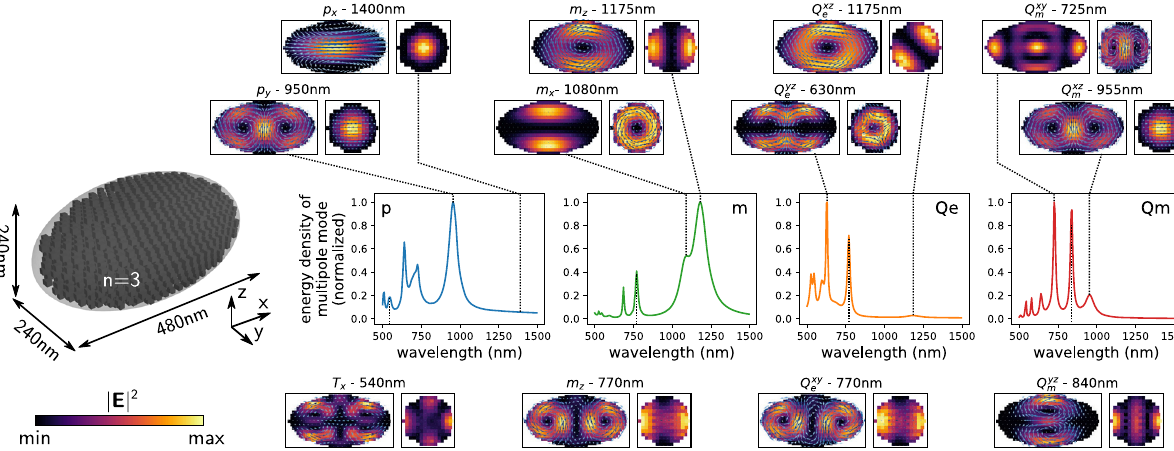
Figure 4: Spectra of the normalized total mode energy density for the different multipoles in a dielectric spheroid of constant refractive = 240 nm, R = 120 nm, and R = 120 nm, in air n = 1. Plotted are the squared sum of the tensor norms index n = 3, with dimensions R env x y z of all generalized polarizability tensors for each multipole order. This is equivalent to the maximal possible radiated energy by the specific multipole moment, assuming it is optimally excited. From left to right: total dipole moment (blue), magnetic dipole (green), total electric quadrupole (orange) and magnetic quadrupole (red). Insets show xy -slices (left subplots) and yz -slices (right subplots) through the spheroid’s center of the electric field intensity and the E -field real part (arrows) upon optimum excitation of the respective modes. The wavelengths are indicated by vertical dashed lines in the